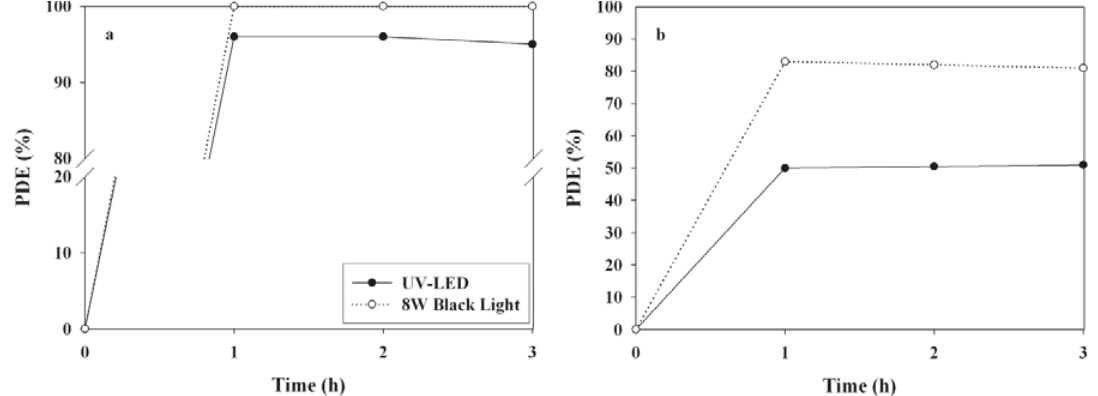
Figure 3. Time-series photocatalytic efficiencies (PDEs, %) of ( a ) 2-propanol; calcined at 450 °C according to light-source type and ( b ) TCE as determined using TiO 2 (8 W black lamp and UV